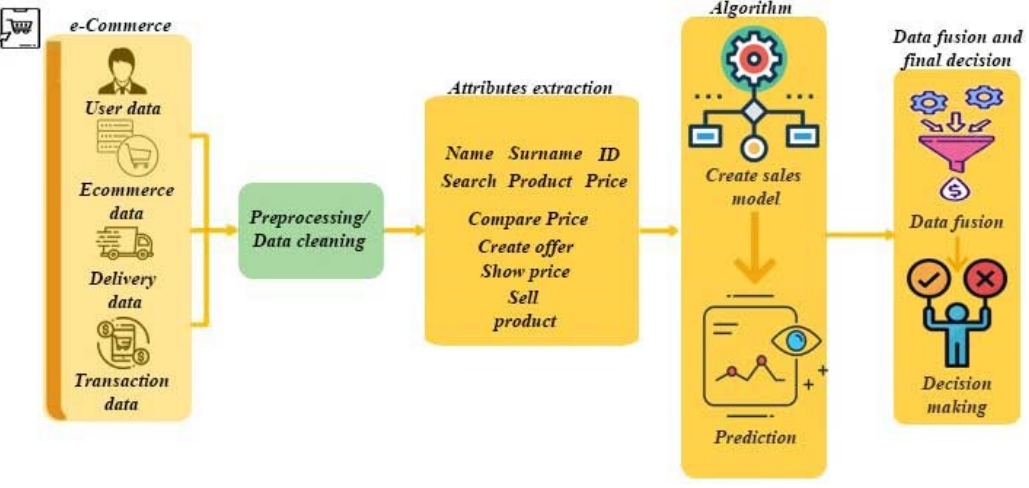
Figure 2. Process flow for data fusion in an e-commerce system.